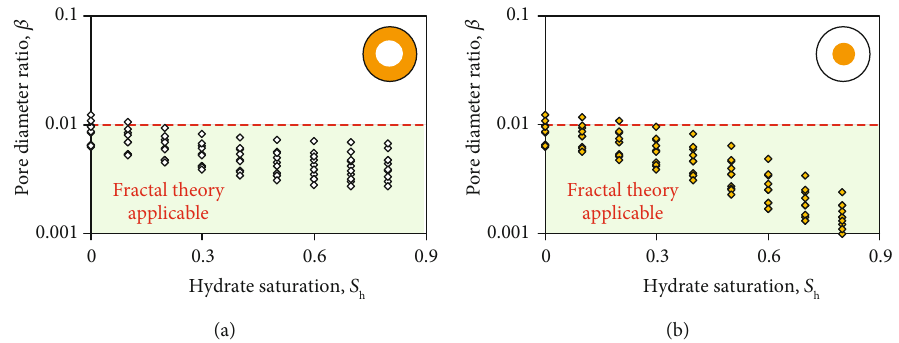
Figure 6: Pore diameter ratio β changing due to the presence of grain-coating (a) and pore- fi lling (b) hydrates within porous media. Regions colored in light green represent fractal theory applicable conditions (i.e., β < 1 : 0 × 10 − 2 ).